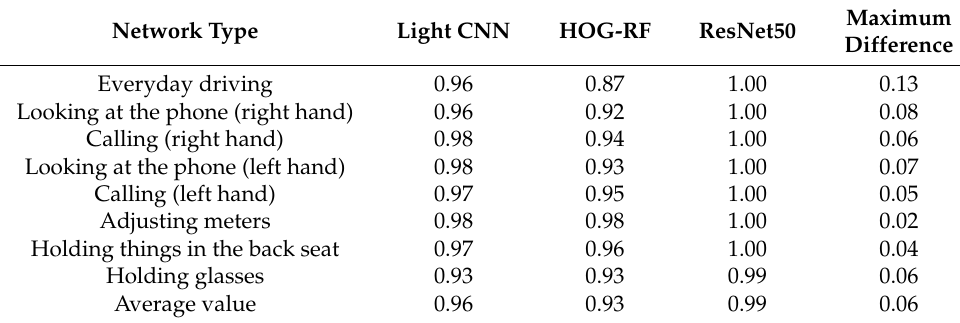
Table 2. ResNet50 vs. HOG-RF and light CNN